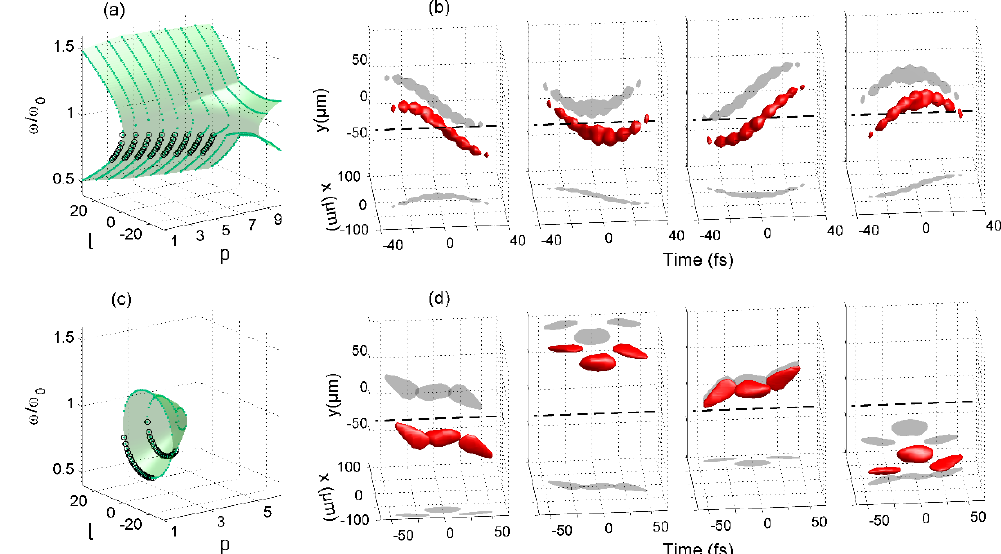
Fig. 1. Examples of helicon wavepackets constructed from phase-matching quadrics of spatiotemporal components in a fused silica rod with radius 𝑅 = 100 µm. (a,c) Quadric surfaces obtained both in normal and anomalous dispersion regimes. Black circles correspond to the selected modes used for the linear construction of helicon wavepackets depicted in (b,d) through iso-surfaces of their spatiotemporal intensity pattern at half-maximum. The successive subplots obtained every 𝜋/(2|𝐾 𝑙 |) confirm the invariant nature of helicon wavepackets over propagation. The dashed line indicates the origin (𝑥 = 0, 𝑦 = 0) . Projections on planes (shadow plots) are provided for a clear observation of